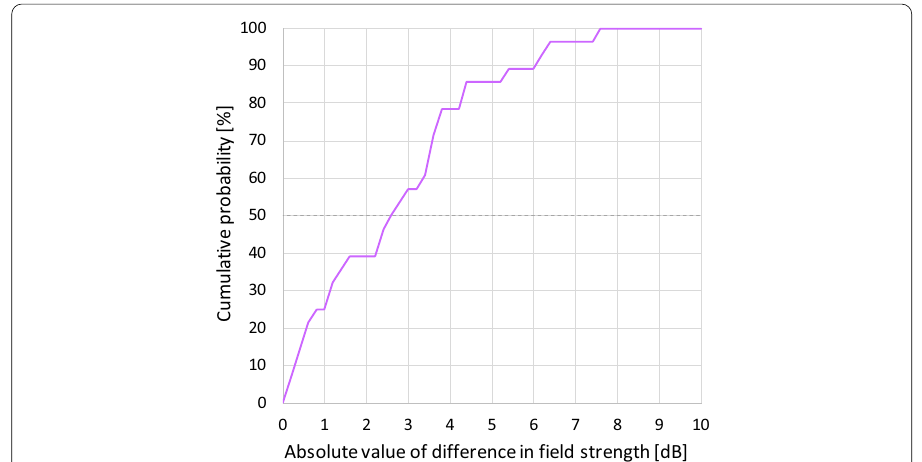
Fig. 15 Cumulative probability of absolute value of difference in field strength between horizontal and vertical in field experiments